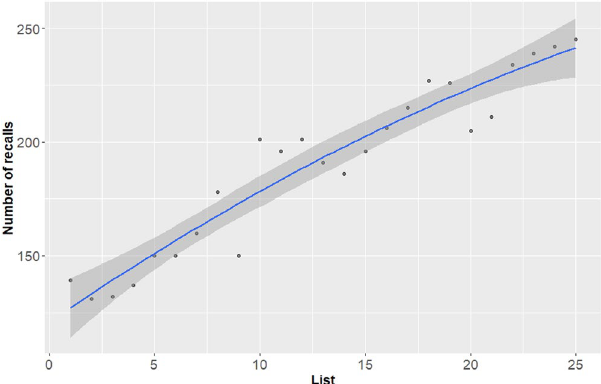
Figure 2. The List-Recency effect. Total number (across all participants) of words recalled per list, collapsed across R and K. A classic list-recency is demonstrated, with higher probability of recalling items from the final lists as compared to the first and middle lists. The blue line denotes the regression